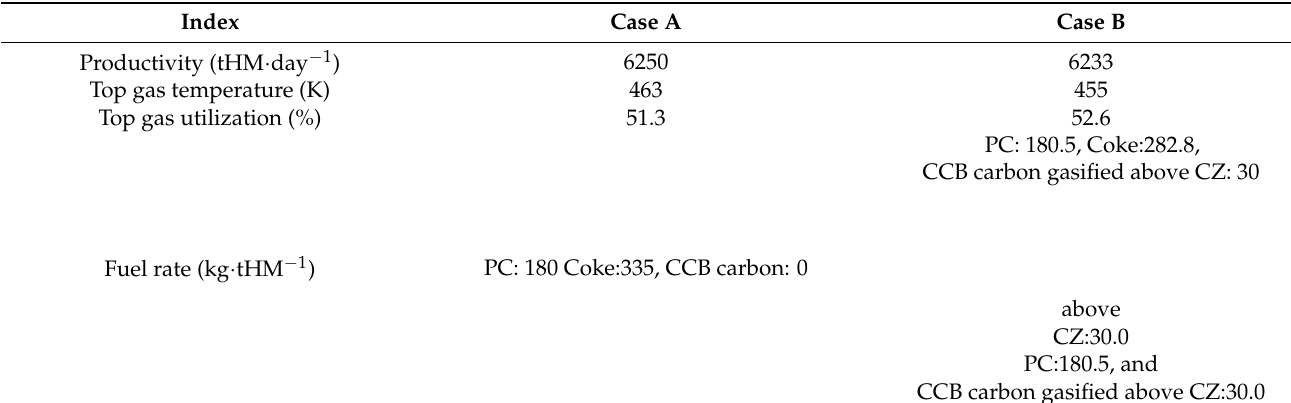
Table 8. Simulation results of some BF indices.